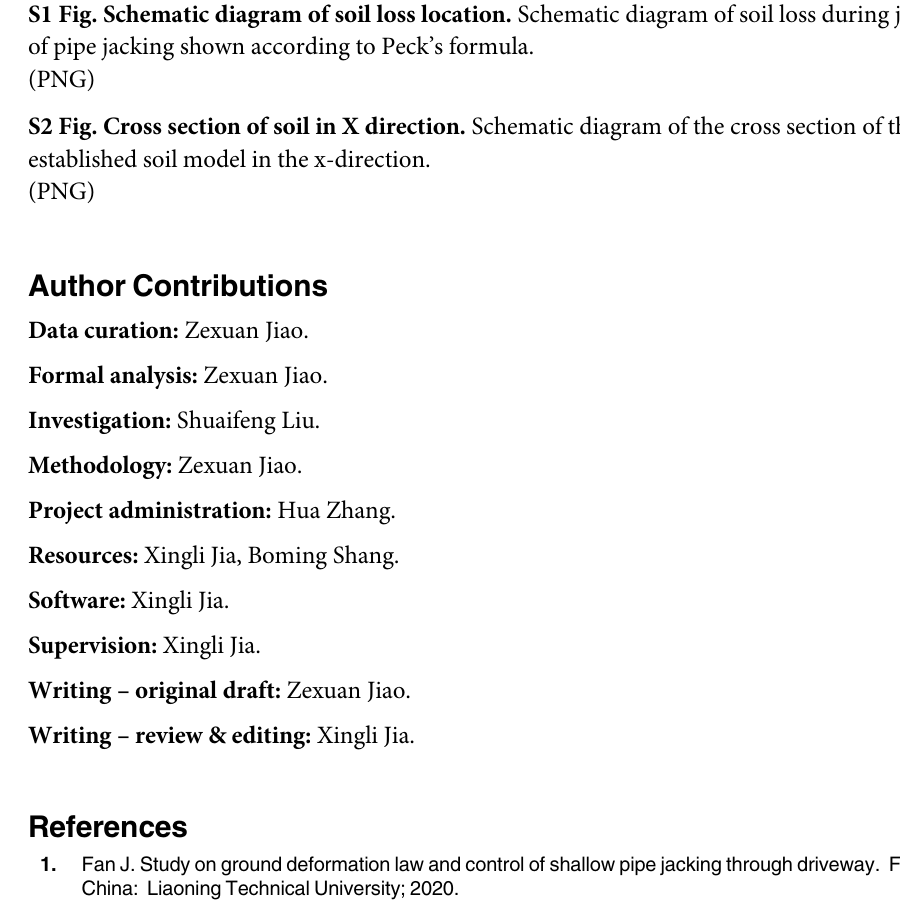
S1 Fig. Schematic diagram of soil loss location. Schematic diagram of soil loss during jacking of pipe jacking shown according to Peck’s formula. (PNG) S2 Fig. Cross section of soil in X direction. Schematic diagram of the cross section of the established soil model in the